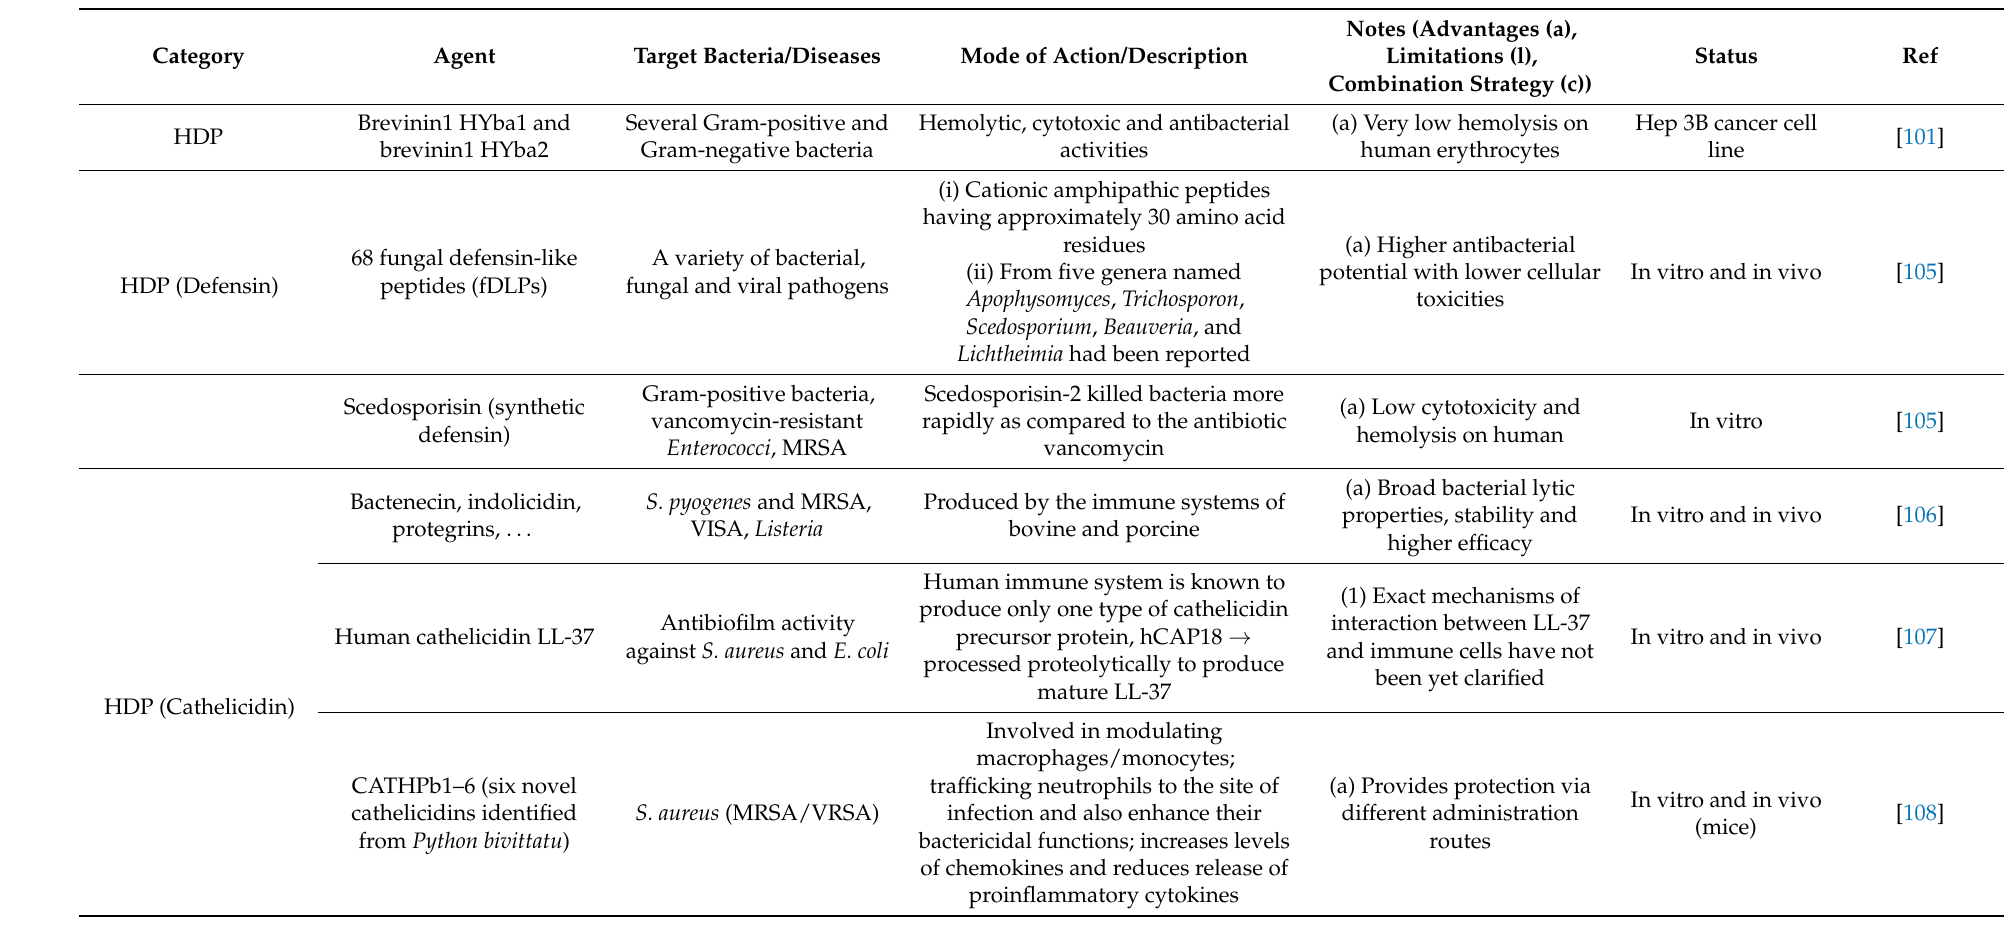
Table 2. Host defense peptides (HDP) against antibiotic-resistant